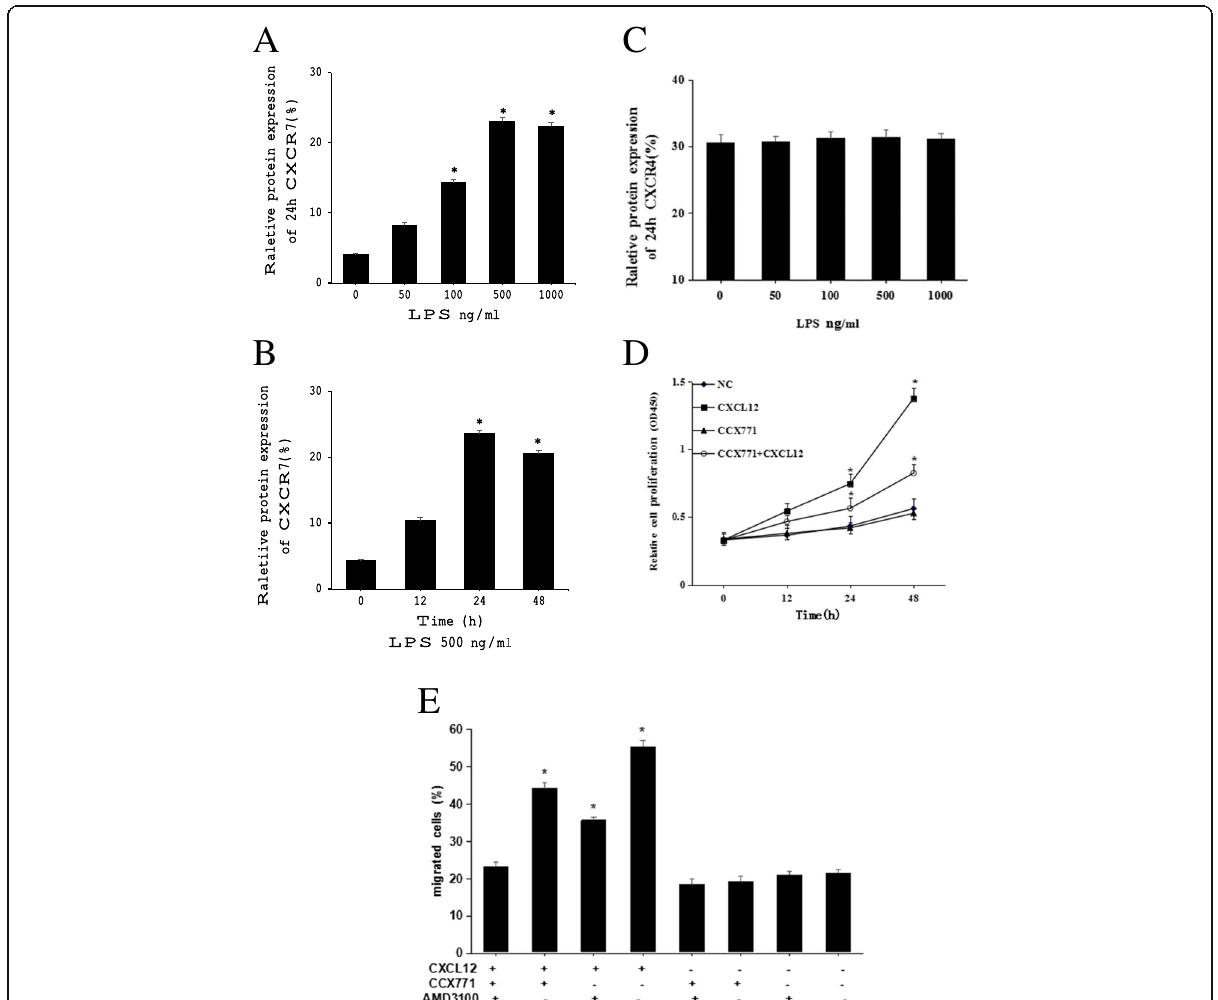
Fig. 2 LPS induced changes in CXCR7 expression in SGC7901 cells. A: CXCR7 protein expression was assessed by western blotting after SGC7901 cells were stimulated for different periods of time with 500 ng/mL LPS; B: SGC7901 cells were cultured with various concentrations of LPS for 24 h, and CXCR7 protein expression was analyzed via western blotting; C: After exposure of SGC7901 cells to LPS (500 ng/ml), CXCR4 protein expression was assessed by western blotting; D and E: After pretreatment with CCX771, SGC7901 cell proliferation and migration were largely inhibited in response to CXCL12 (100 ng/ml) after 48 h of incubation with LPS. *, P < 0.05, vs. the NC group. The data are presented as the mean ±